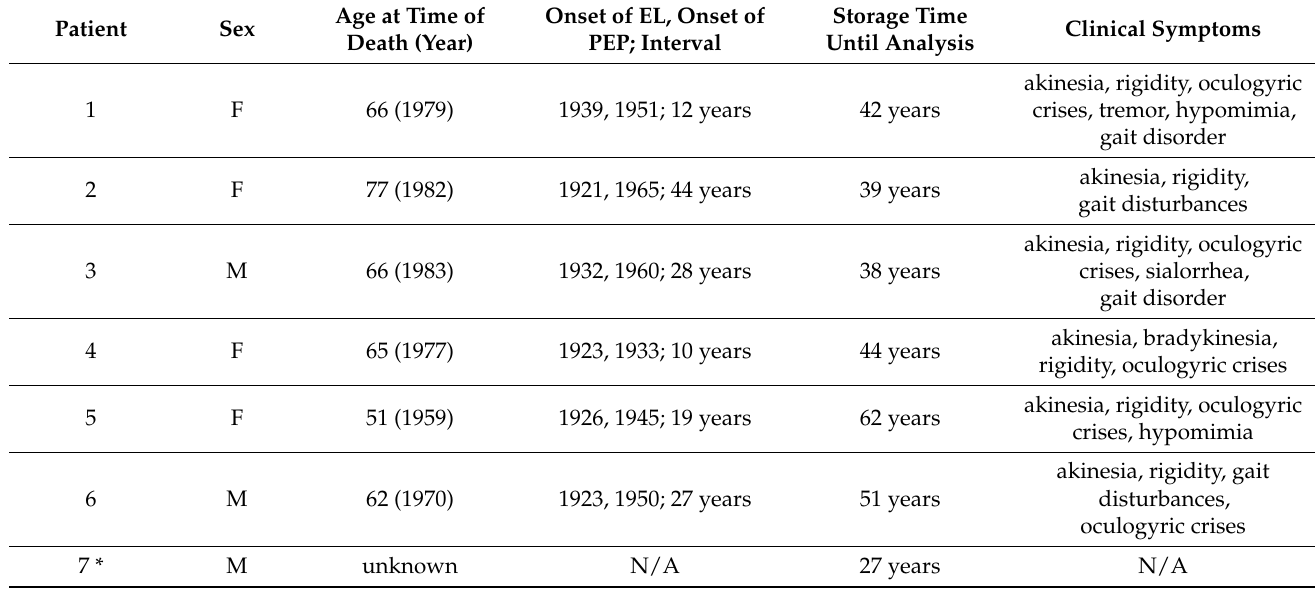
Table 1. Clinical characteristics of patients with postencephalitic parkinsonism in this